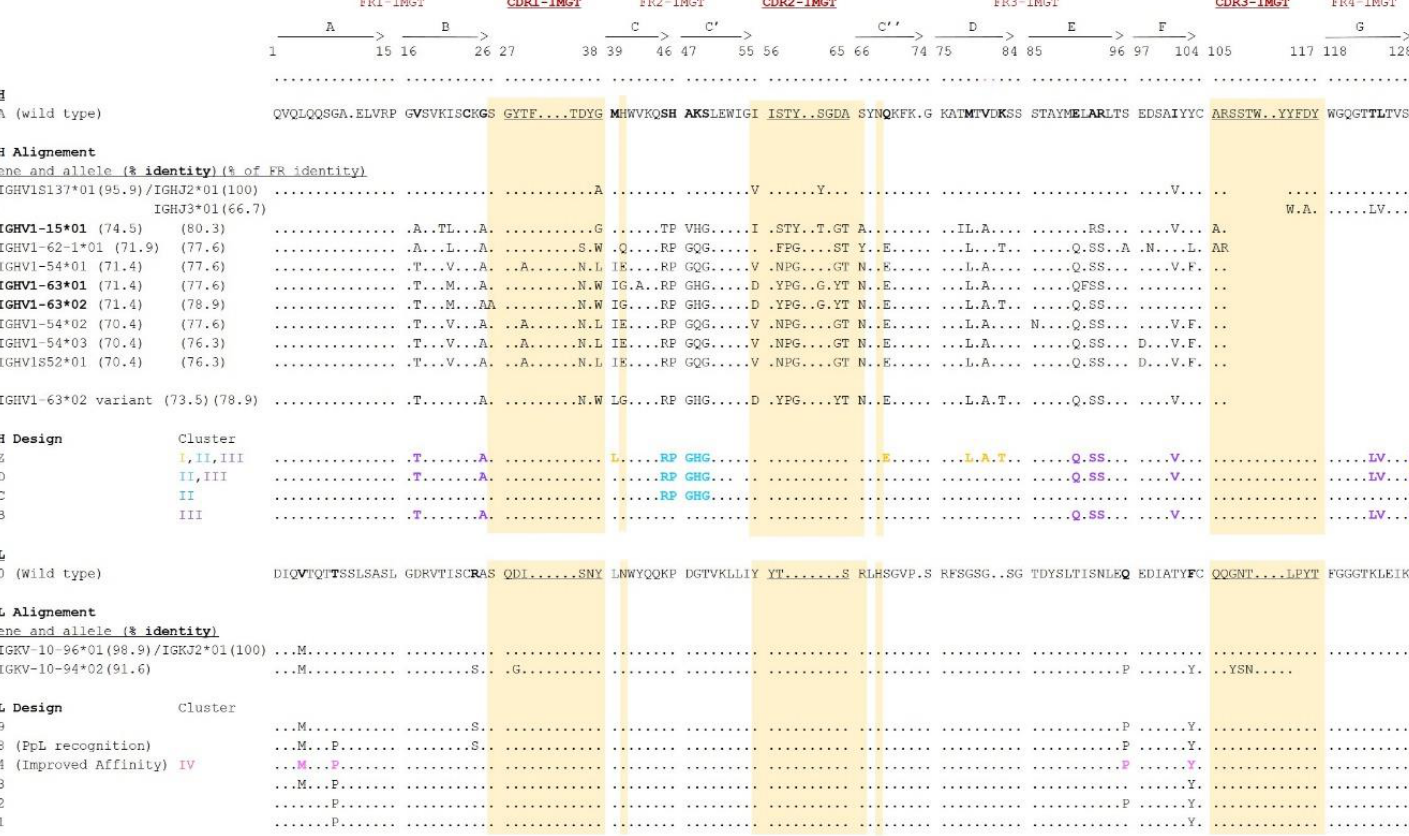
Figure 3. Amino acid sequence of heavy-chain variable (VH) and light-chain variable (VL) domains according to the IMGT ® numbering. The wild-type sequences of the VH and VL domains were aligned according to the IMGT®/DomainGapAlign feature. Only sequences with the highest percentage of identity and sequences of interest were shown. The different sequences of the VH and VL domains were designed without taking into account the amino acid residues present in extended CDRs (depicted in yellow). Only mutations performed on both domains were shown. For the VH and VL domains, mutated residues are stained according to the clusters they belong to (cluster I: orange; cluster II: blue; cluster III: purple and cluster IV: pink).